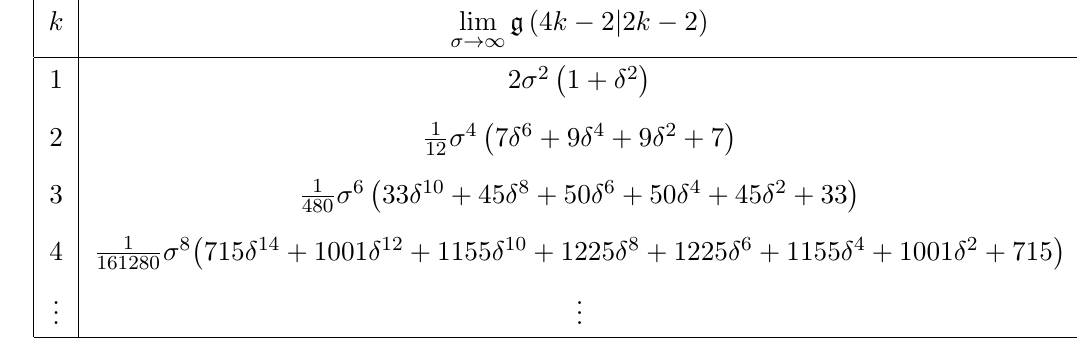
2 2 k 2) in the (cid:27) (cid:0) j (cid:0)